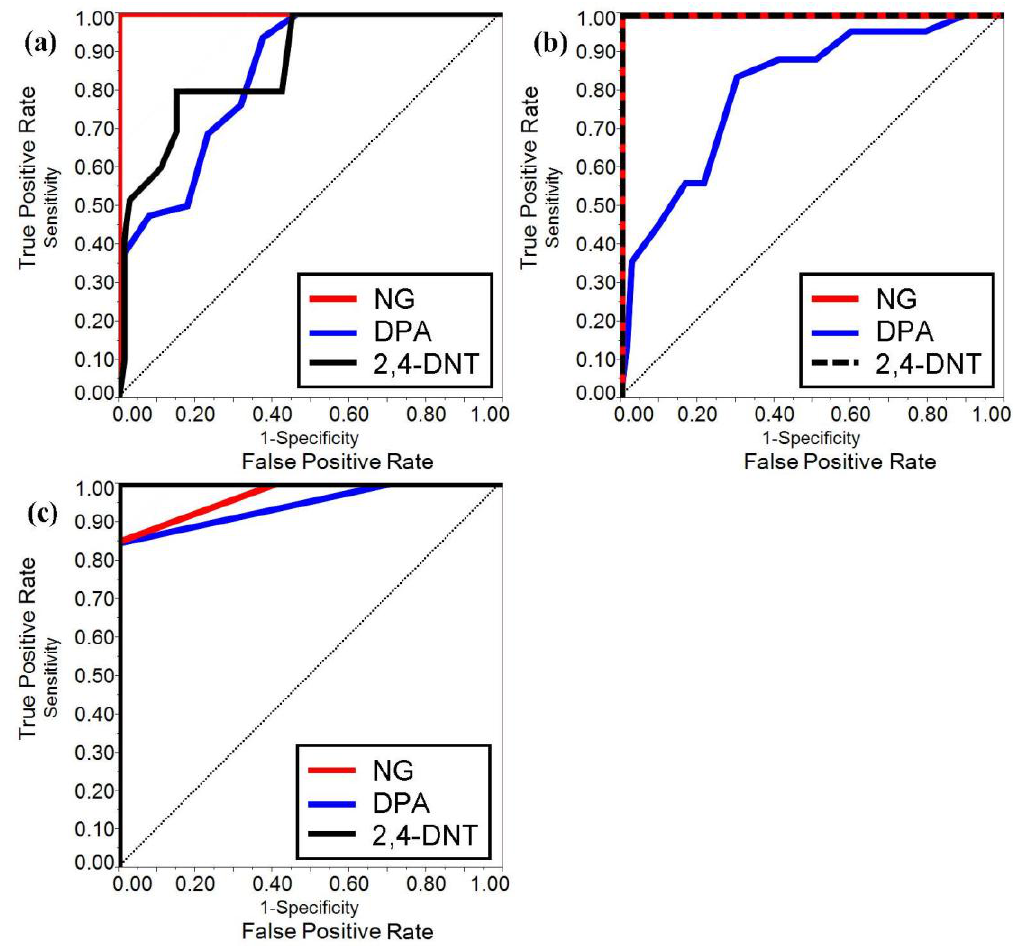
Figure 4. ROC curves for the portable PSPME-IMS ( a ), benchtop PSPME-IMS ( b ) and laboratory based SPME-GC-MS ( c ). These ROC curves were constructed using JMP software from 360 samples (140 samples for SPME-GC-MS) including all defined